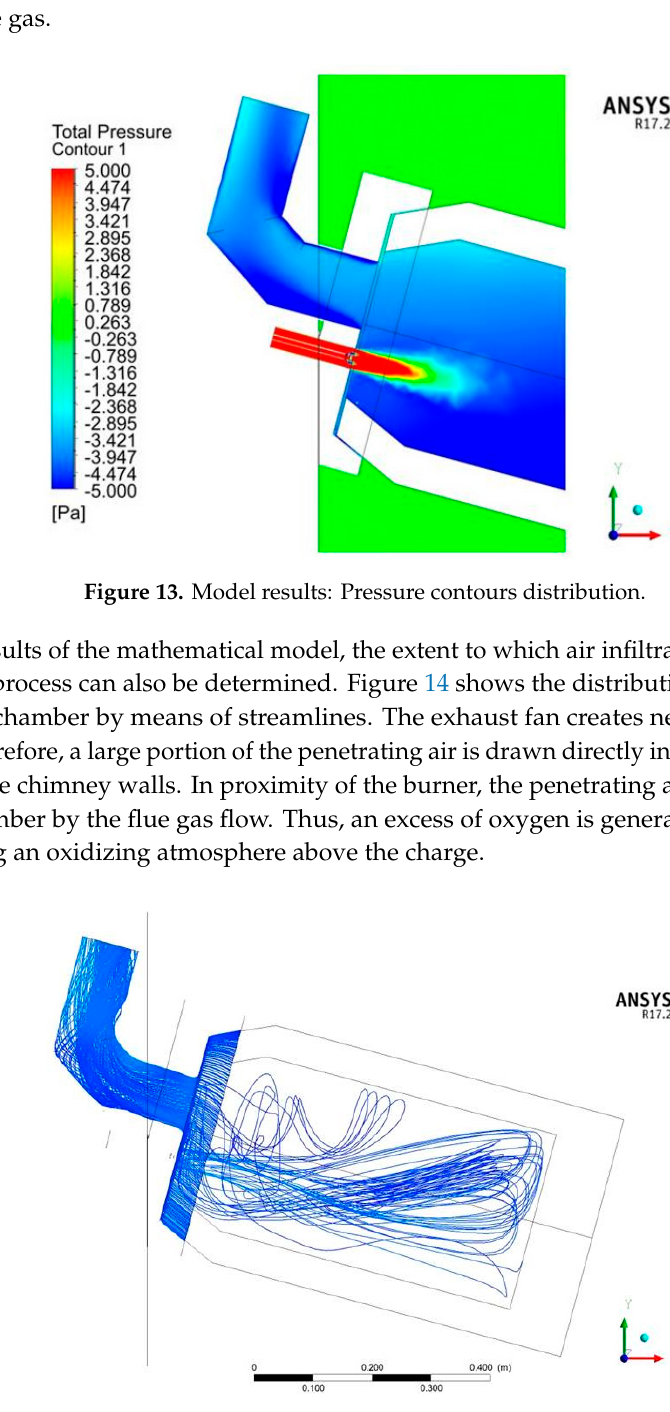
Figure 14. Model results: Infiltrating air flow contours in the combustion chamber.